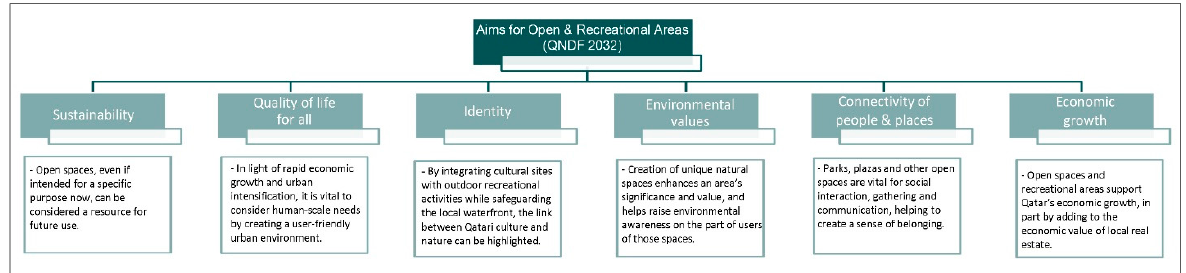
Figure 16. Desirable attributes of open and recreational areas (MME, 2020).